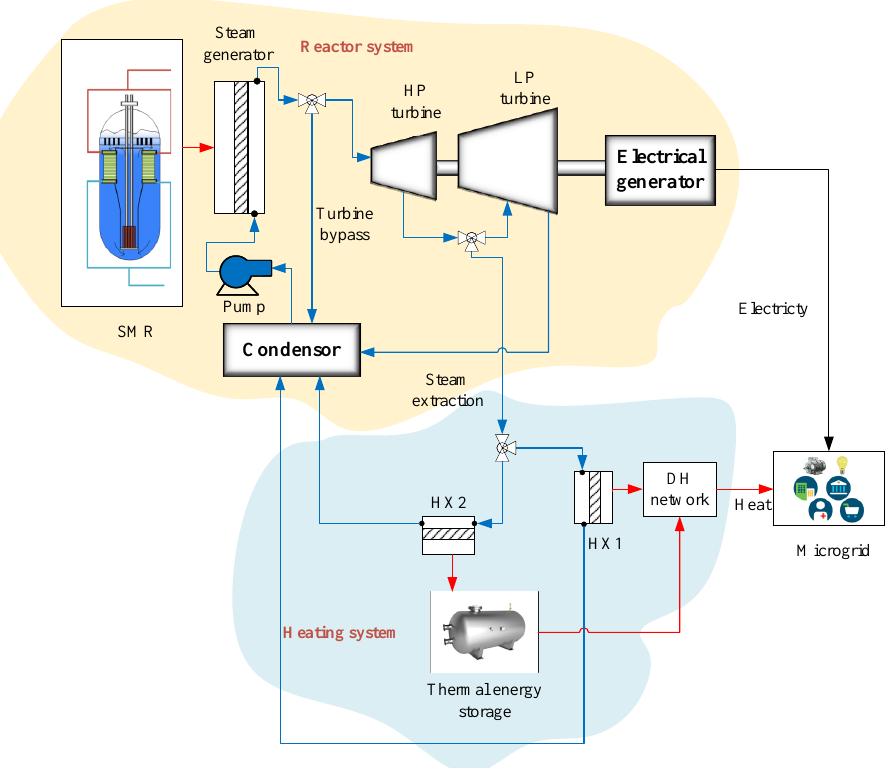
Figure 3. Distribution of steam produced by an